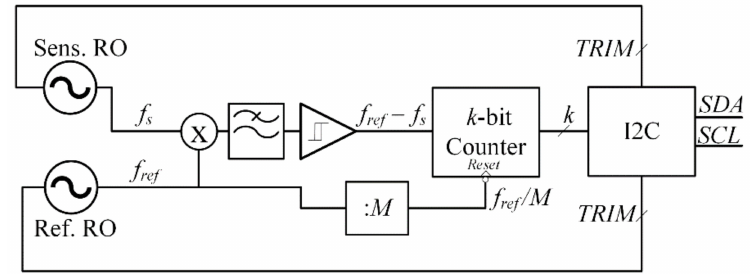
Figure 1. Block diagram of the proposed